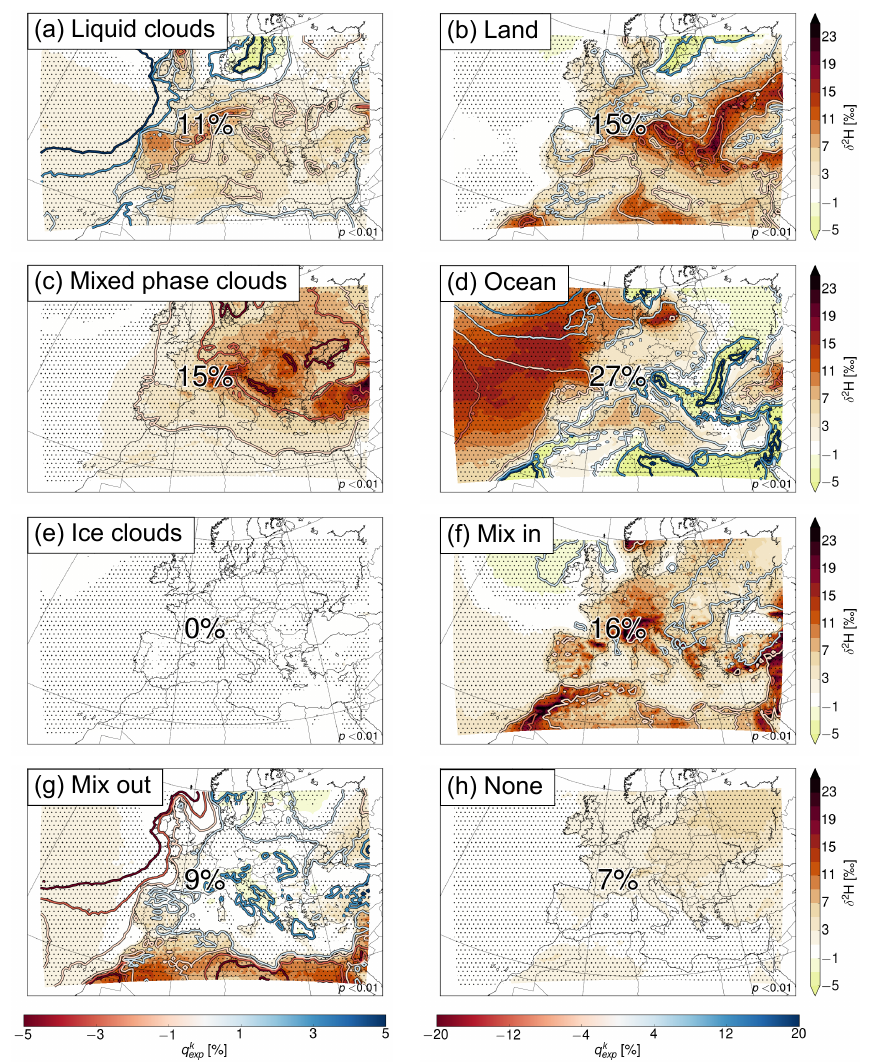
Figure 11. Contributions of the processes to the daily (cid:49)δ 2 H in Fig. 10c. The numbers show the mean contribution of each process, and the contours show the difference in q k exp (see Eqs. 10 and 11) between the high and low anomaly days in %. Stippling indicates areas where p < 0 . 01. Note the different colour scales for q k exp between the left- and right-hand